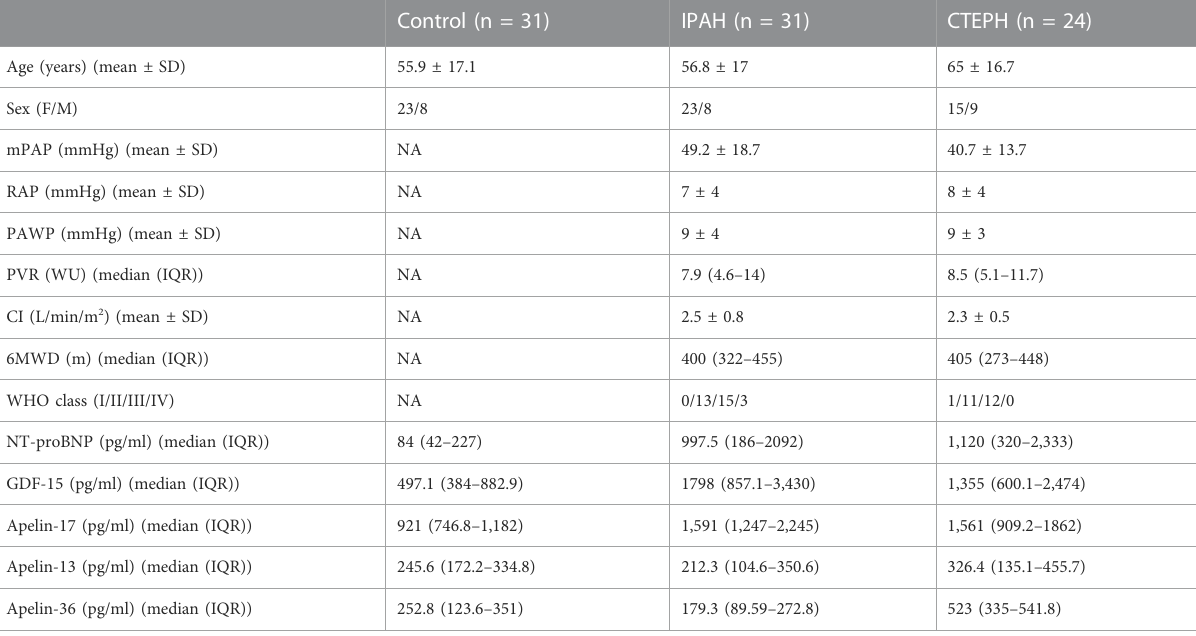
TABLE 1 Patients ’ characteristics. Values are expressed as mean ± standard deviation (mean ± SD) or median and interquartile range (median (IQR)).